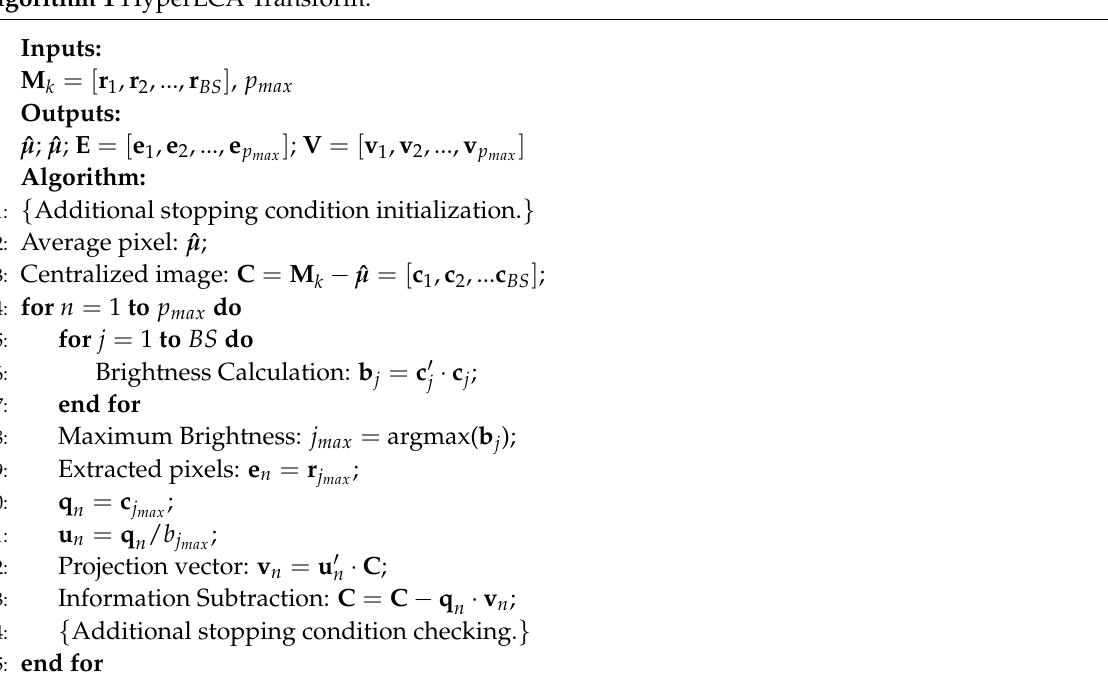
Algorithm 1 HyperLCA